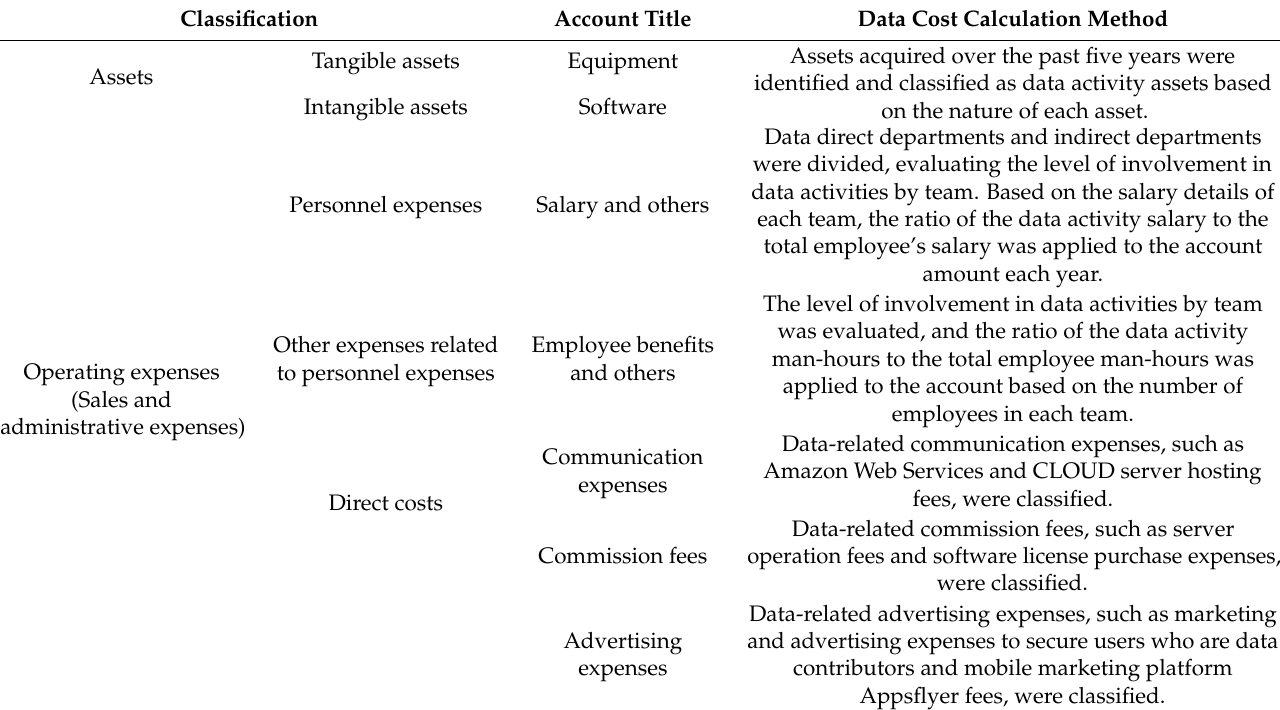
Table 2. Data cost calculation method by data operating asset and